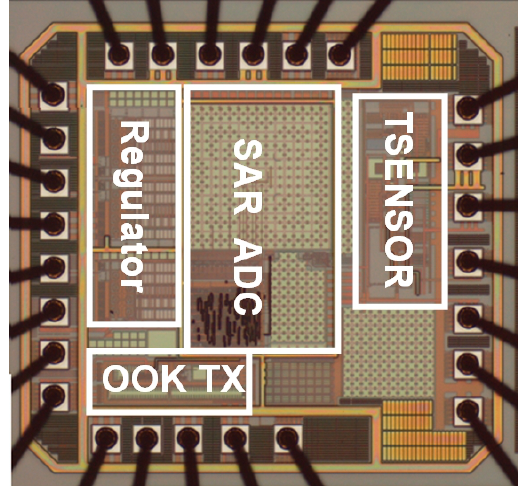
Figure 14. Micrograph for chip and wire